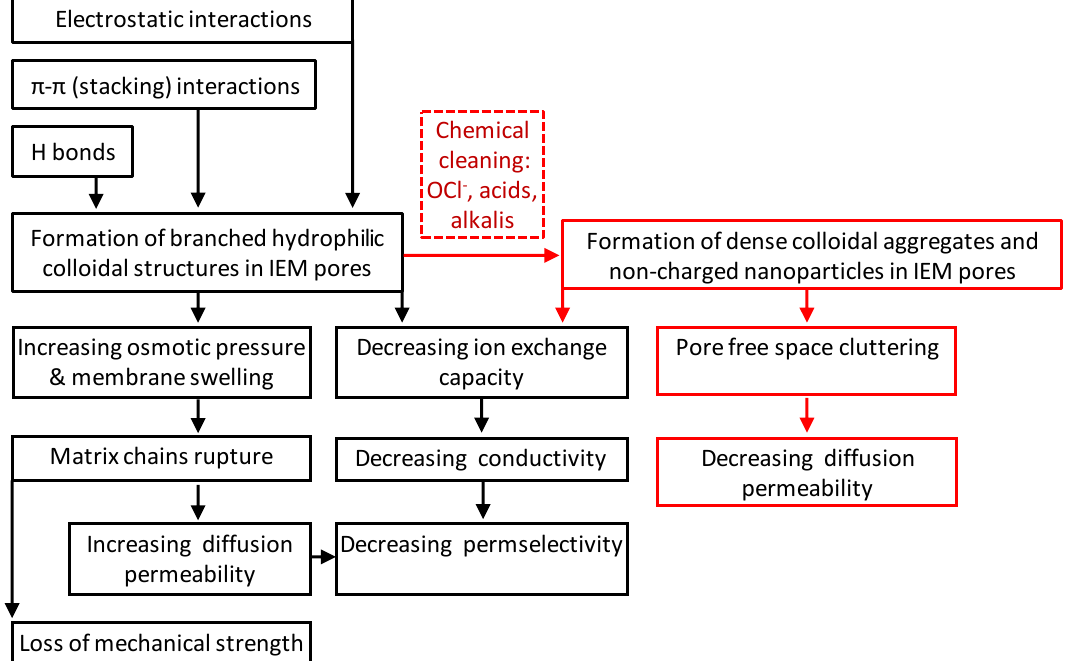
Figure 5. The main types of interaction of polyphenols with ion-exchange membranes and the effect of this fouling on the transport characteristics of IEMs.